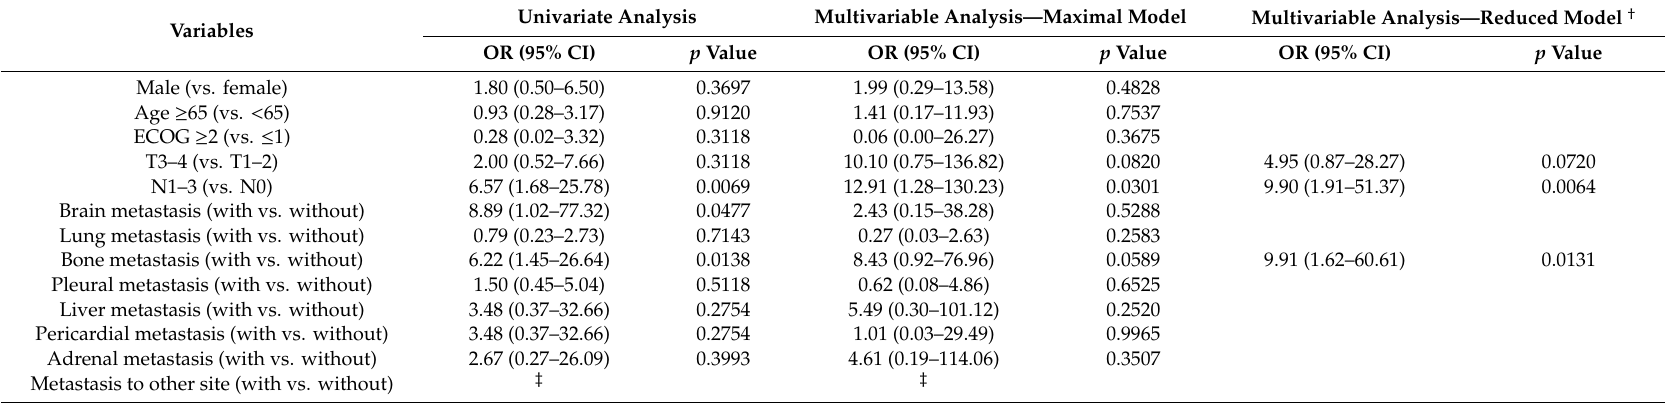
Table A2. Predicting factors for concordant EGFR mutation detected in liquid / tissue biopsy (only patients using Qiagen ® EGFR RGQ PCR kit for their tissue